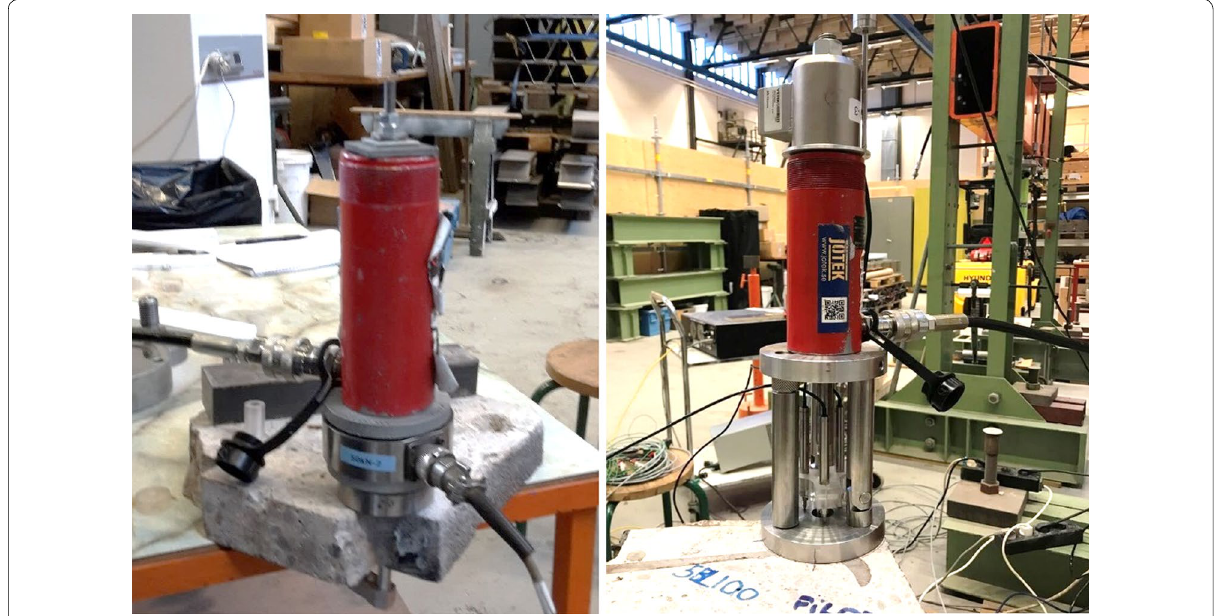
Fig. 11 Pull-out test setup, (left) in pilot test and (right) with developed